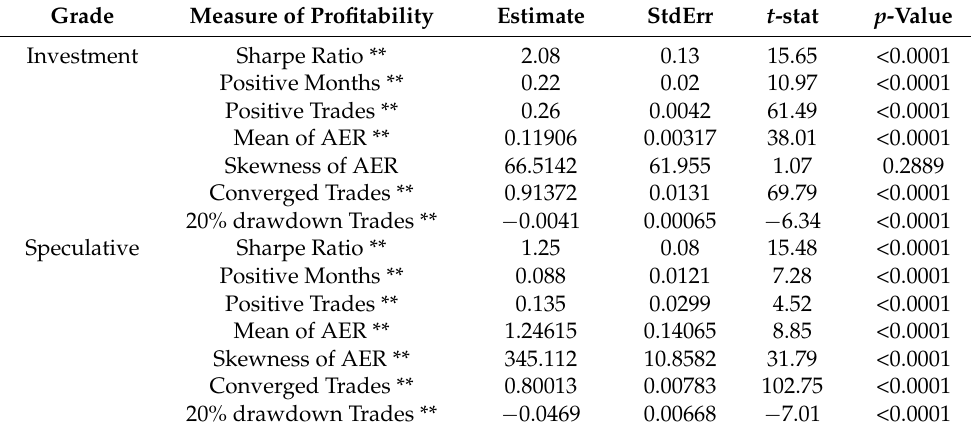
Table 5. TS2 vs. Yu [27].